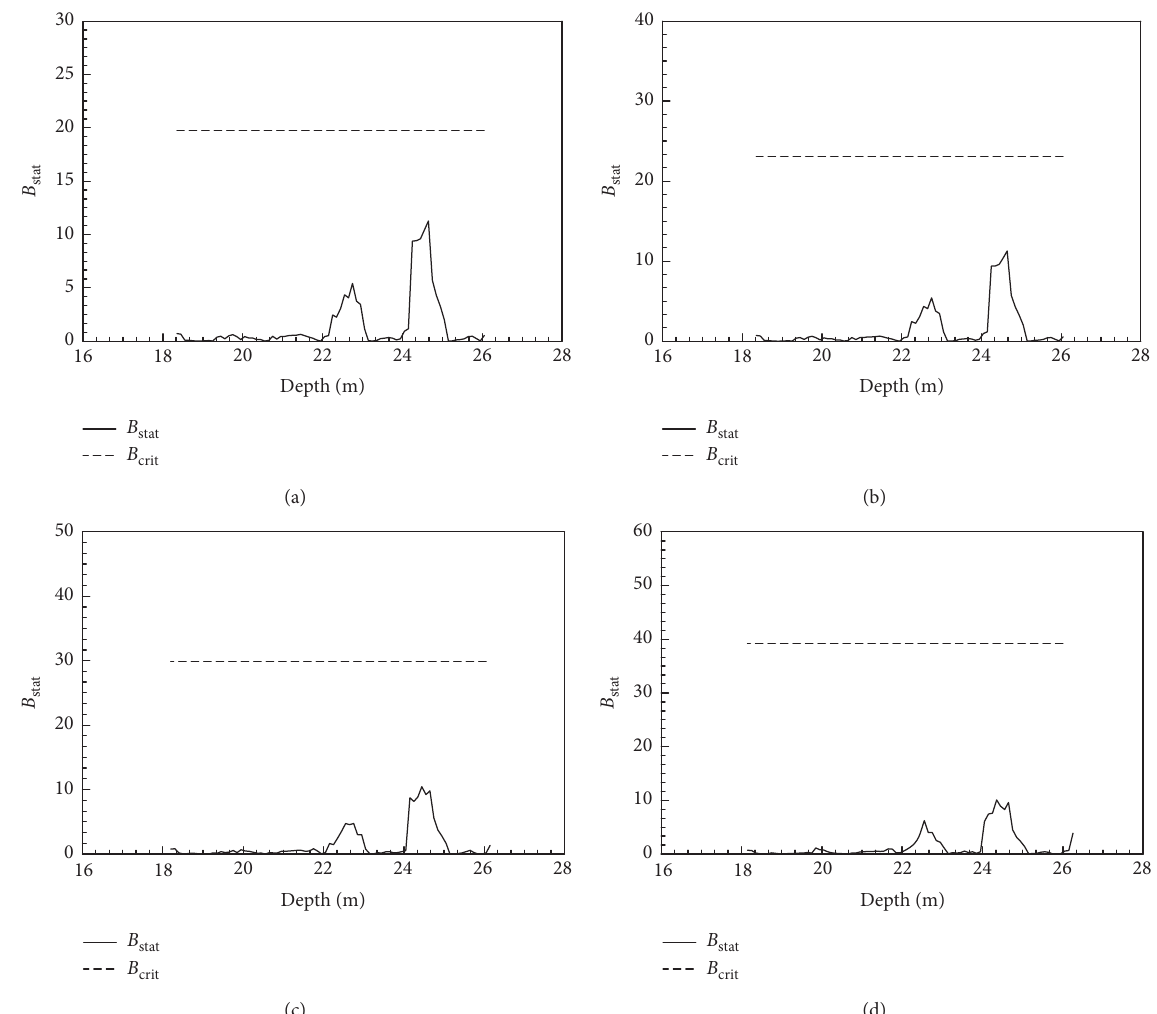
Figure 4: Modified Bartlett statistic profiles of CPT data for the medium clay layer. (a) M